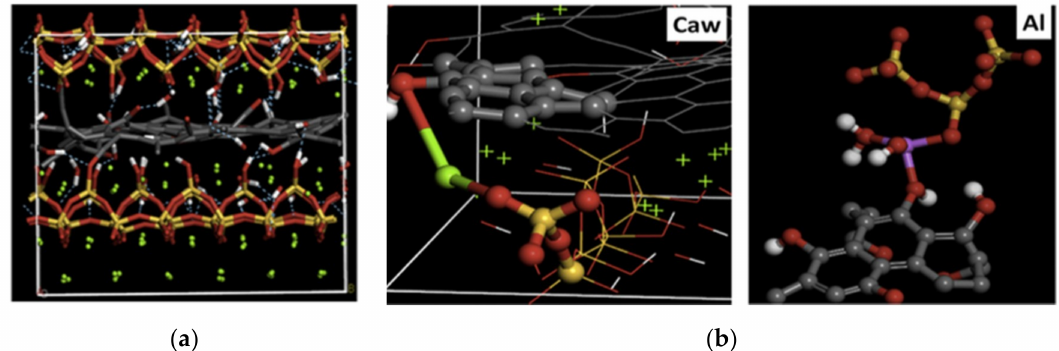
Figure 12. Molecular structure of the ( a ) GO / C–S–H; ( b ) oxygen–calcium–oxygen bond (O–Ca–O) and oxygen–aluminum–oxygen bond (O–Al–O) connecting the neighboring GO and C–S–H. The ball-stick styles represent the composite model. Oxygen, calcium, carbon, silicon, hydrogen, and aluminum atoms are represented by red, green, gray, yellow, white, and purple balls, respectively. The hydroxyl, C–C, and silicate bonds are represented by white-red, gray, and yellow-red sticks, respectively. Reproduced from [105], with permission from Elsevier, 2019.